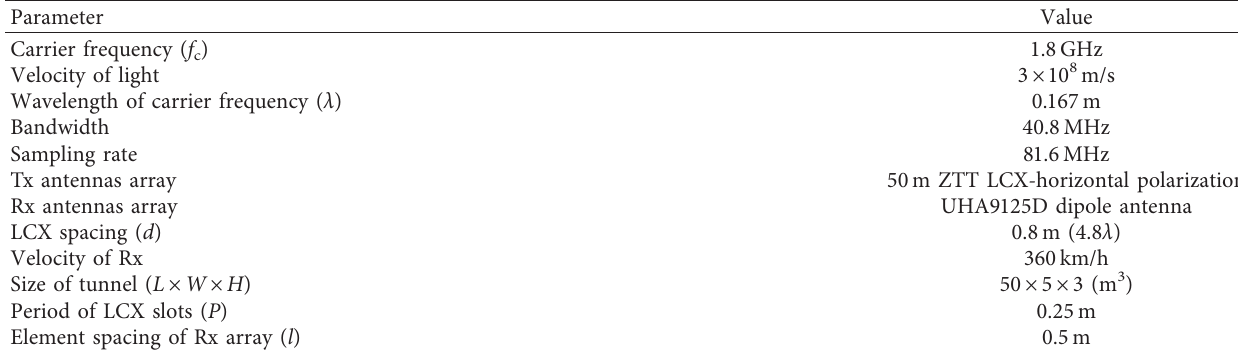
Table 2: Experiment parameters.